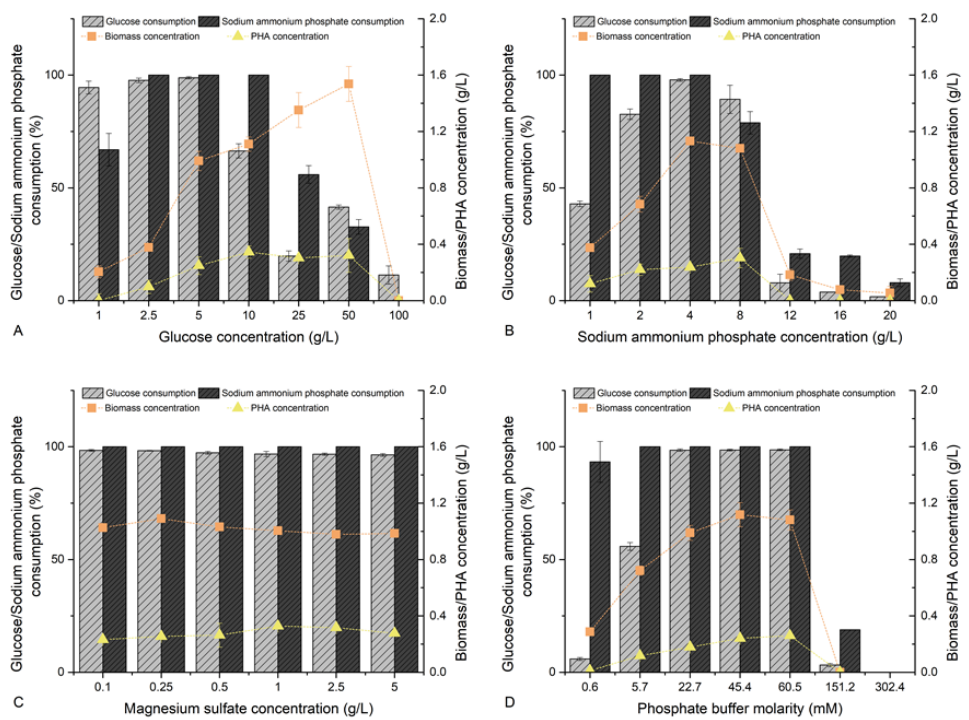
Figure 2. The influence of a selected component of the propagation medium ( A )—glucose concen- tration (g/L); ( B )—sodium ammonium phosphate concentration (g/L); ( C )—magnesium sulfate concentration (g/L) and ( D )—phosphate buffer molarity (mM)) on the monitored variables. The concentrations of parameters not investigated in a propagation medium were 5.0 g/L glucose, 4.0 g/L sodium ammonium phosphate, 0.25 g/L MgSO 4 ·7H 2 0 and 60.5 mM phosphate buffer.